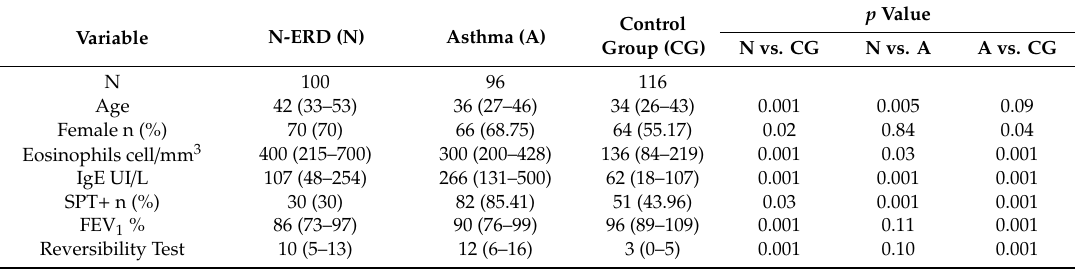
Table 5. Demographic and clinical characteristics of the included subjects in the second